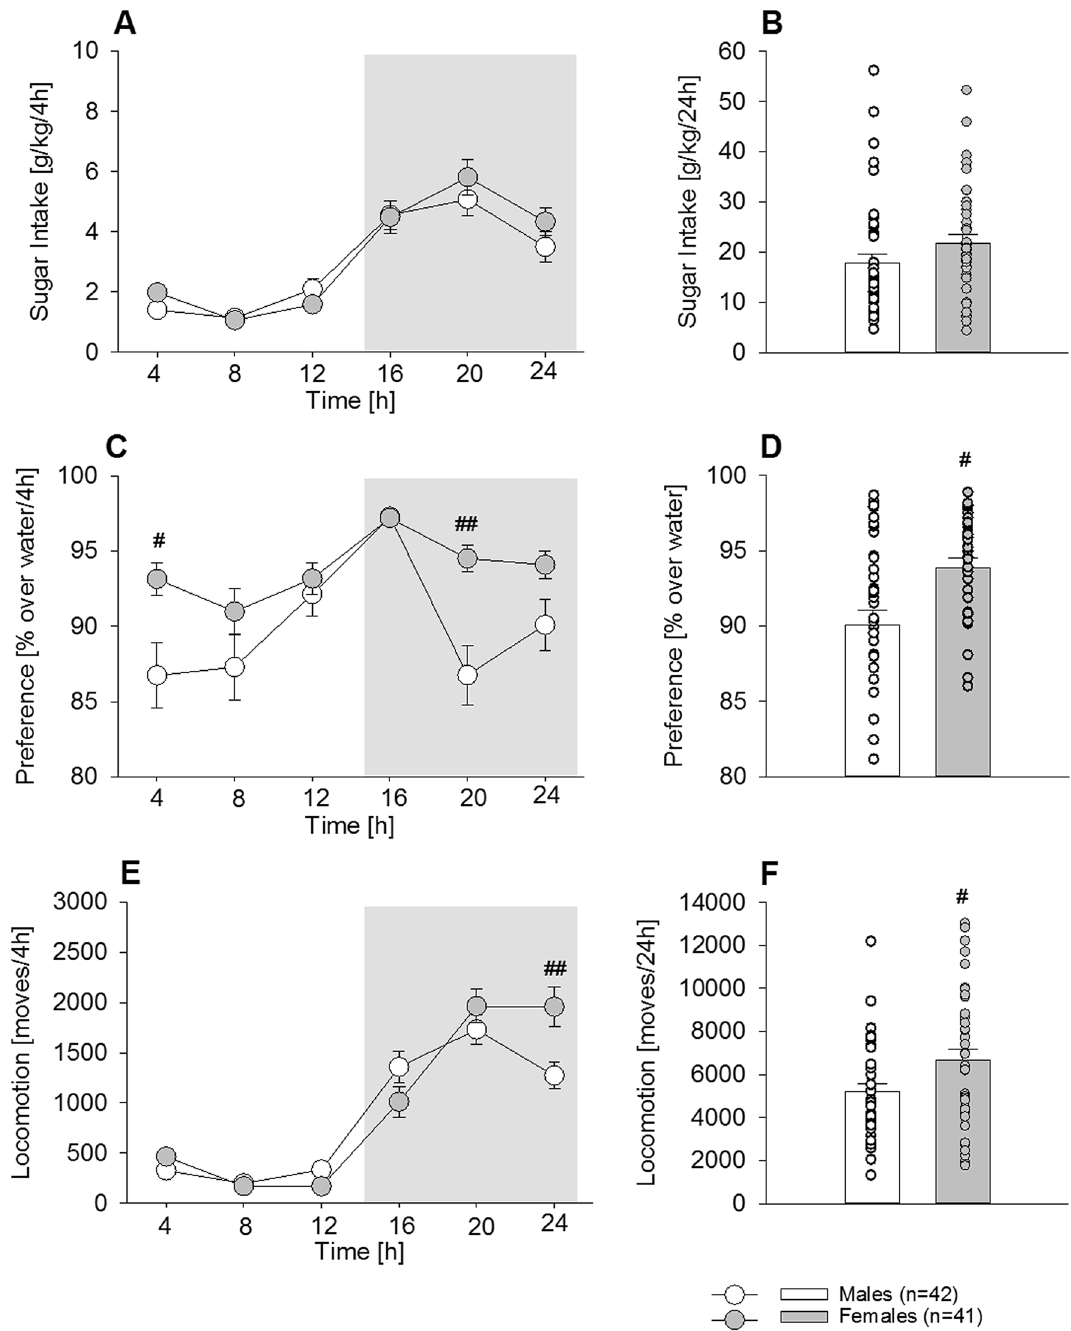
Figure 2. Acquisition of sugar consumption in male (n = 42) and female (n = 41) mice (Experiment 2a). Sugar drinking ( A , B ), preference over water ( C , D ) and locomotor activity ( E , F ) during the first 3 days of free choice sugar exposure. ( A ) Both males (white circles/bars) and females (grey circles/bars) showed the typical diurnal rhythmicity, with higher drinking levels during the dark, active phase compared with the light, inactive phase of the day with no differences between males and females (all day points differed significantly from all night points, not indicated). ( B ) Consequently, the total sugar intake during 24 h was similar in both groups. ( C ) Such rhythmicity was not that marked in the daily preference over water but the mean showed a clear diurnal pattern, with females showing higher preference between the end of the active and beginning of the inactive phase, ( D ) which resulted in a higher total preference compared to males. ( E ) Similar to the intake pattern, locomotor activity also showed the typical diurnal rhythmicity (all day points differed significantly from all night points, not indicated). Females showed higher locomotor activity which was restricted to the active phase. ( F ) As a result, the total daily locomotor activity was higher in females than in males All data represent means ± SEM. (#), (##) indicate P < 0.05 and 0.001 versus male mice,